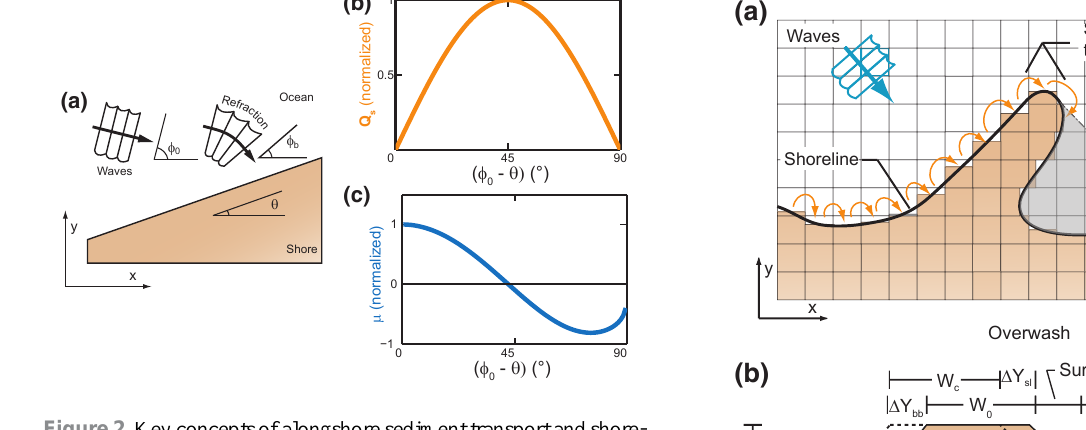
Figure 2. Key concepts of alongshore sediment transport and shore- line instability: (a) plan view showing axes and reduction of wave angle due to refraction, (b) normalized alongshore sediment trans- port, Q s , as a function of offshore wave angle, and (c) normalized shoreline shape diffusivity, µ , as a function of deep-water wave an- gle.